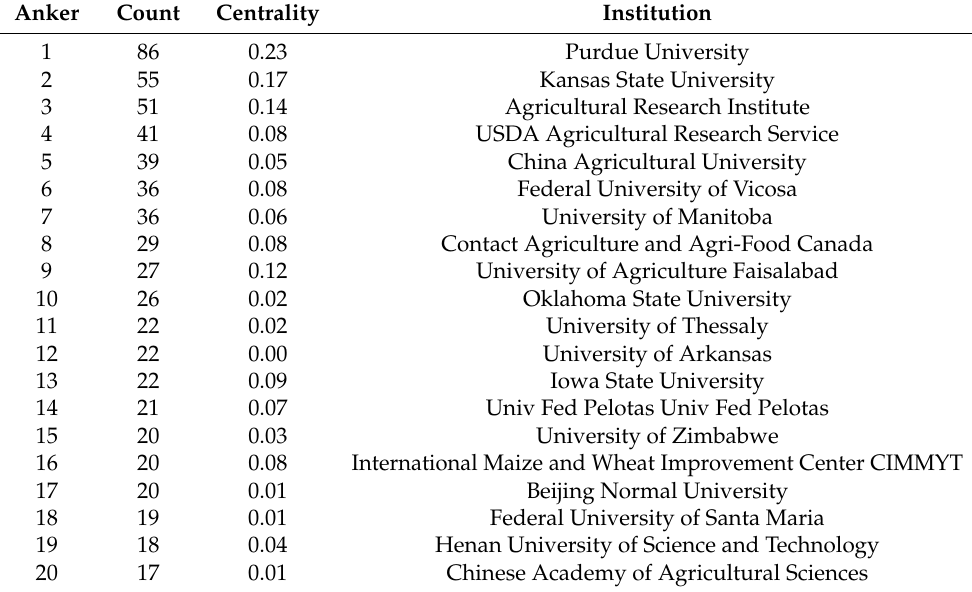
Table 4. Information table of the top 20 major research institutions with published